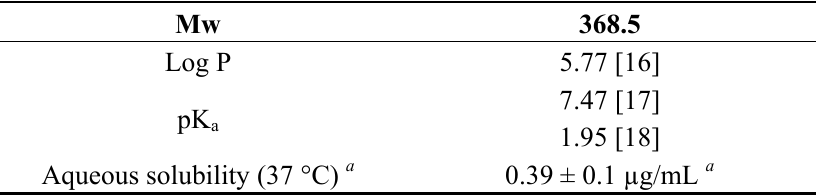
Table 1. Selected Physiochemical Properties for Cinnarizine.